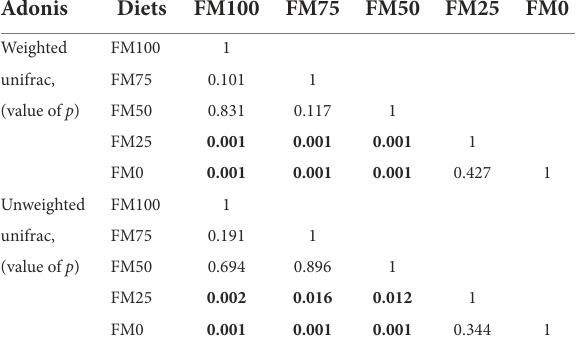
TABLE 2 The PERMANOVA Pair-wise test for the gut microbial community from largemouth bass fed with different levels of Chlorella meal diets. Bold values represent statistically significant differences between groups. FM100 represents the fishmeal diet without Chlorella meal; FM75, FM50, FM25, and FM0 represent the fishmeal diet with 25, 50, 75, and 100% fishmeal replacement by Chlorella meal, respectively.